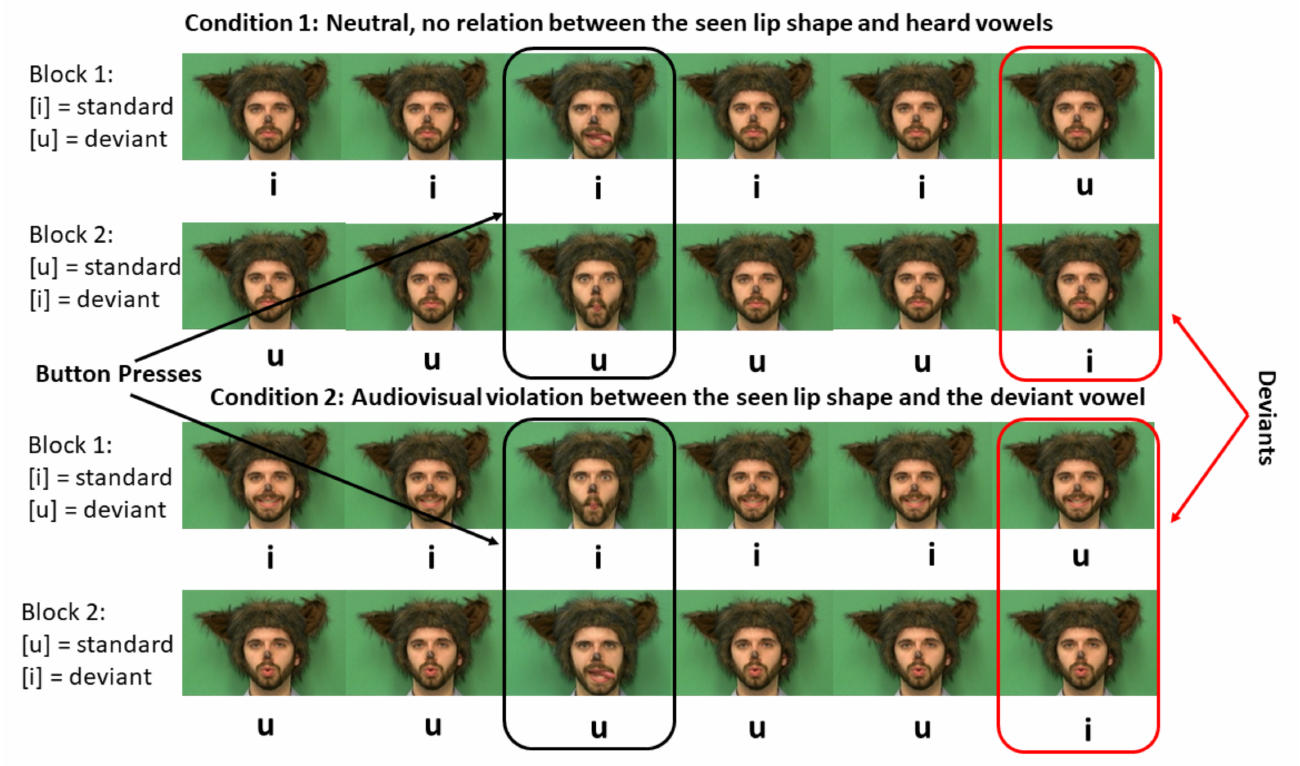
Figure 1. Experimental Design. Note that children pressed a response button every time they saw the wolf do something silly. No responses were provided for stimuli that served as experimental